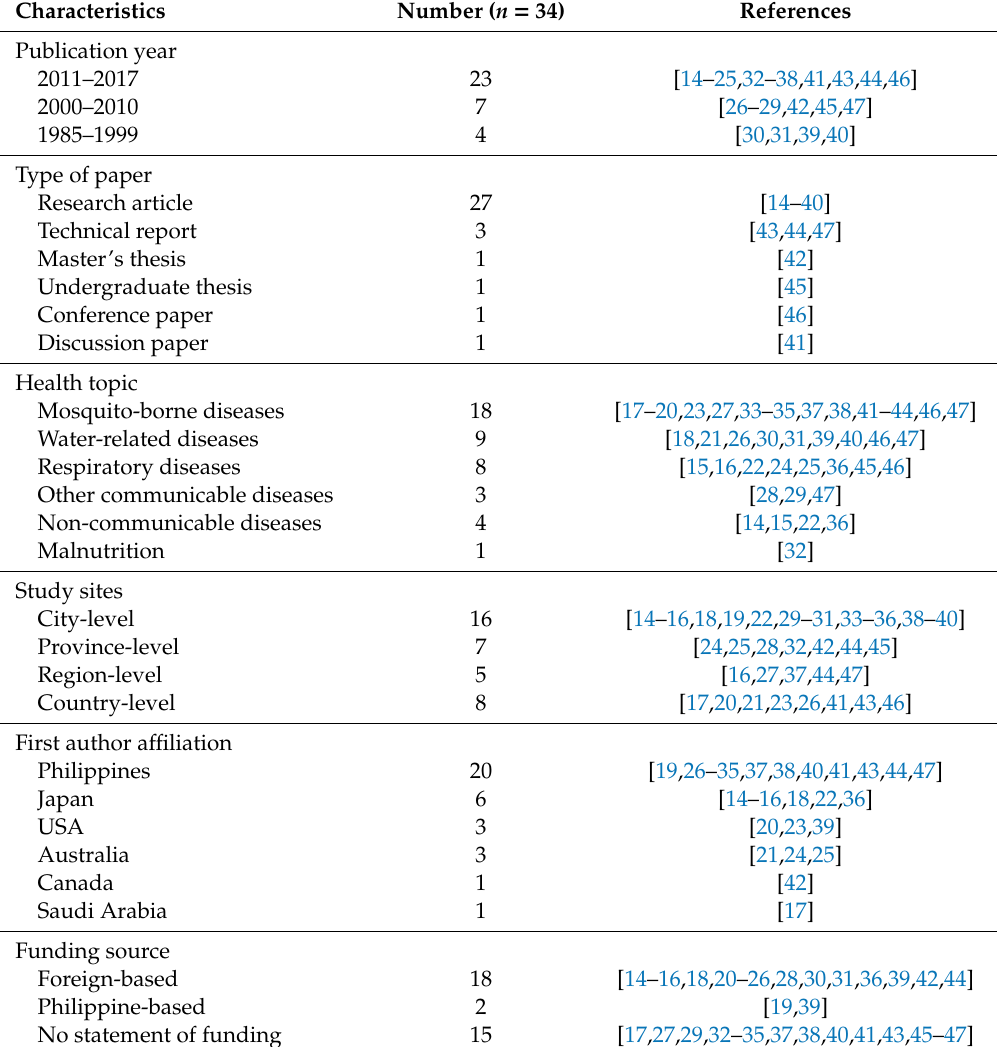
Table 3. General characteristics of selected